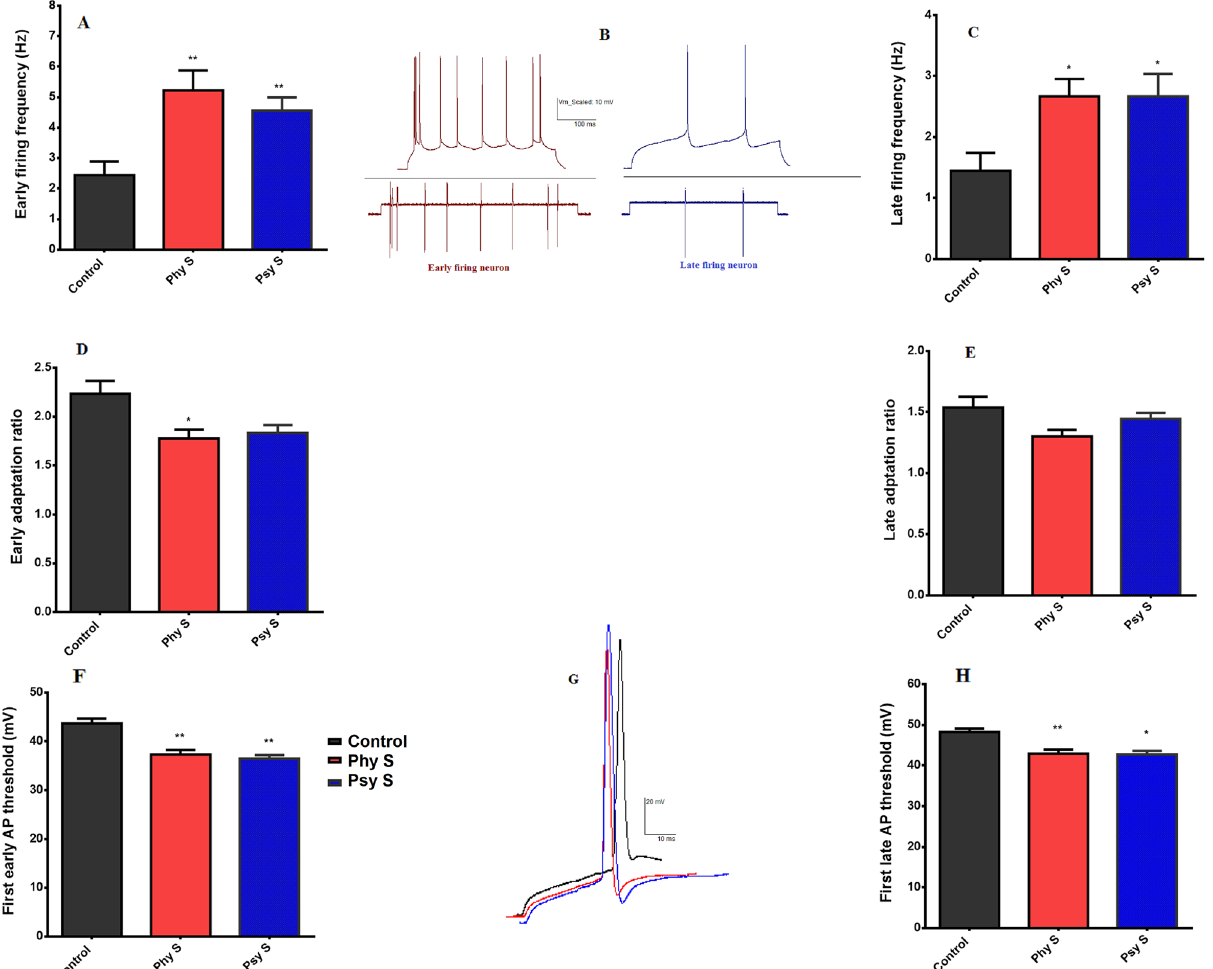
Figure 6. Injection of 100 pA positive current for 500 ms after clamping at − 70 Mv in offspring of physical and psychological prenatal stressed mothers. ( A ) Firing frequency of early-firing neurons. (B) Firing pattern of early- and late- firing neurons. ( C ) Firing frequency of late-firing neurons. ( D ) Adaptation ratio of early-firing neurons. ( E ) Adaptation ratio of late-firing neurons. ( F ) AP threshold of early-firing neurons. ( G ) AP pattern of early- and late- firing neurons. ( H ) AP threshold of late-firing neurons. Data are represented as Mean ± SEM. * ( p < 0.05), ** ( p < 0.01) shows a significant difference compared to the control group. Phy S: Physical stress, Psy S: Psychological